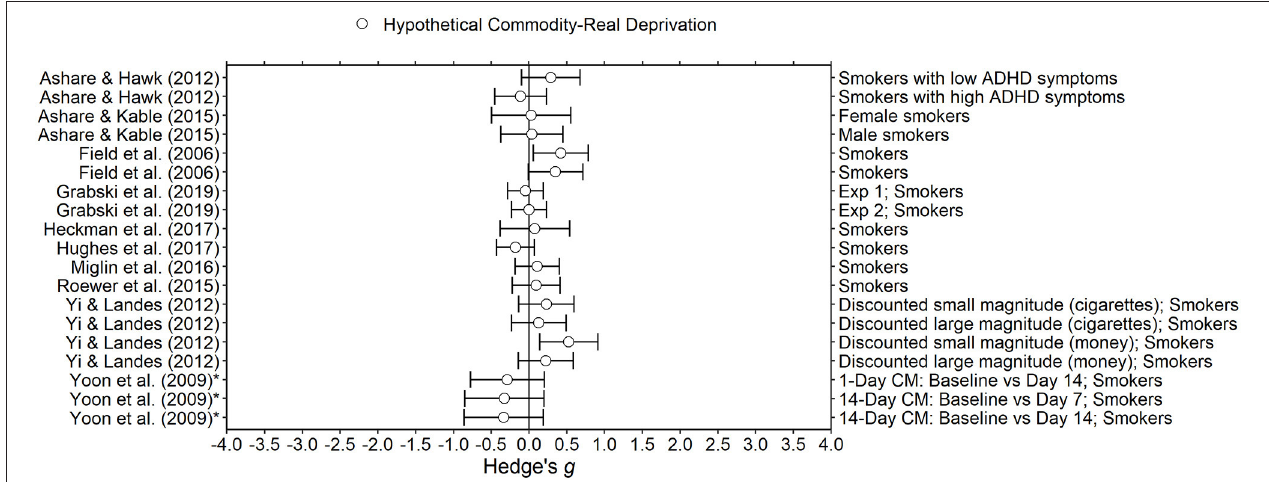
FIGURE 3 | Effect sizes for nicotine deprivation experiments. Effect size is Hedge’s g . Points closer to 0 indicate smaller effect sizes. Points to the right of the line indicate increases in delay discounting due to deprivation, the predicted effect. Subjects discounted hypothetical outcomes and experienced real deprivation. *Indicates the effect size was calculated using non-transformed k-values and thus may be